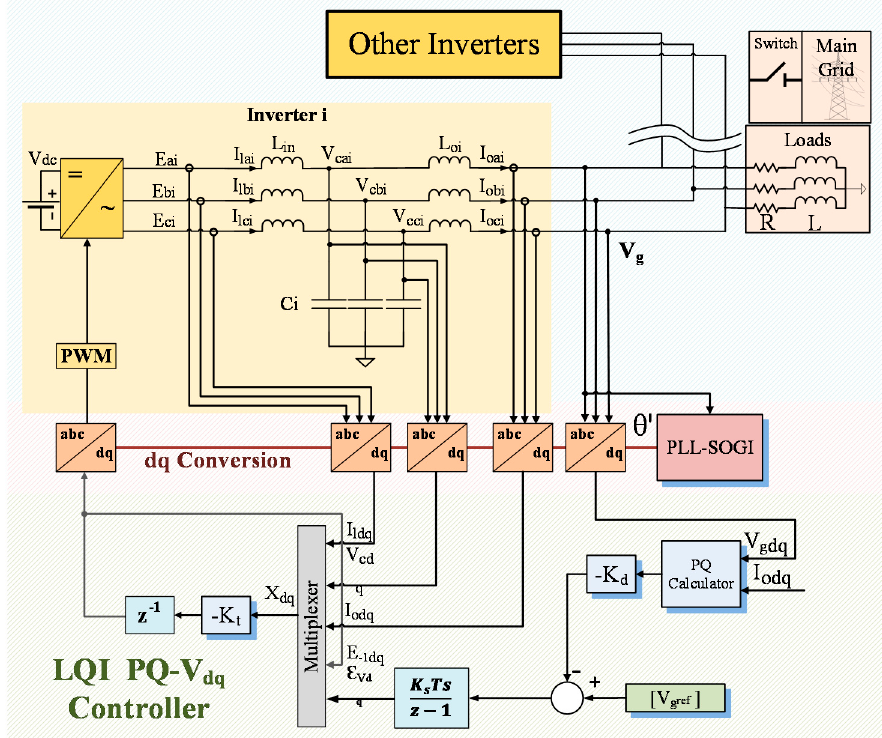
Figure 22. Control scheme for the PQ/Vdq controller.